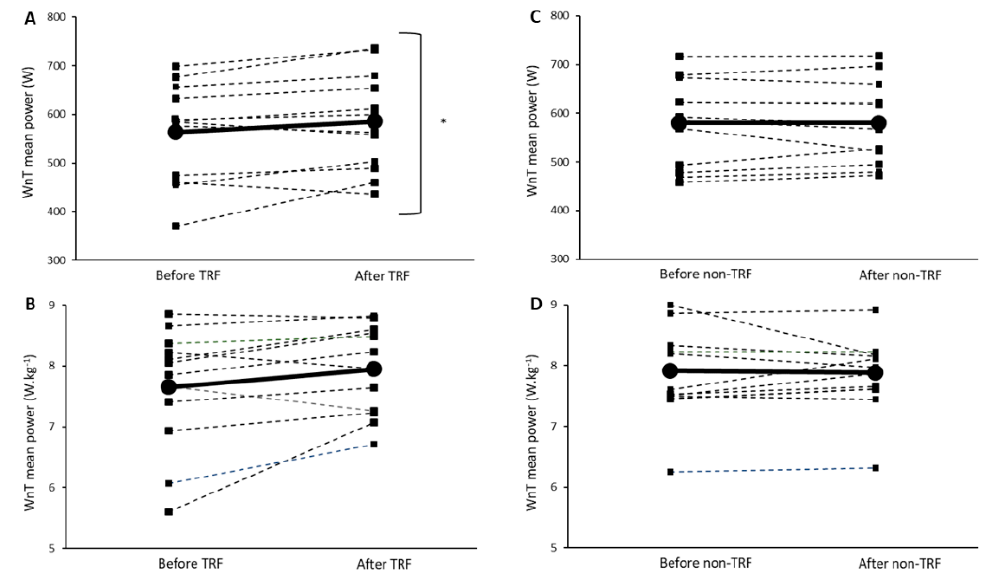
Figure 2. Wingate (WnT) mean power output obtained in response to 4 weeks of time-restricted feeding (TRF) and non-time-restricted feeding (non-TRF). Absolute ( A ) and relative ( B ) mean power in response to TRF. Absolute ( C ) and relative ( D ) mean power in response to non-TRF. Relative values were computed by dividing absolute power by the individual body mass. Values are mean ± SD. Dashed lines represent individual participants. The solid black line represents the mean value of all cases. * Significant differences between time points ( p < 0.05).